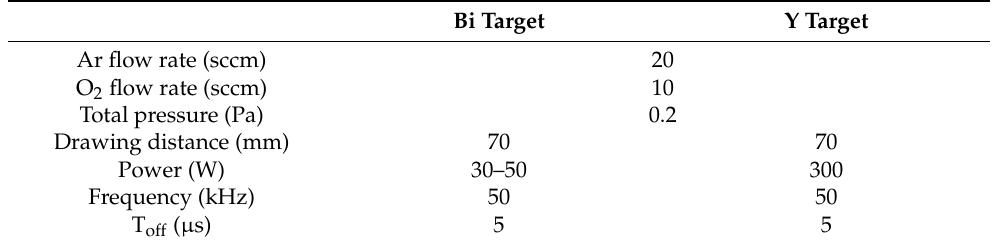
Table 1. Sputtering parameters for deposition of yttria-stabilized bismuth oxide films.